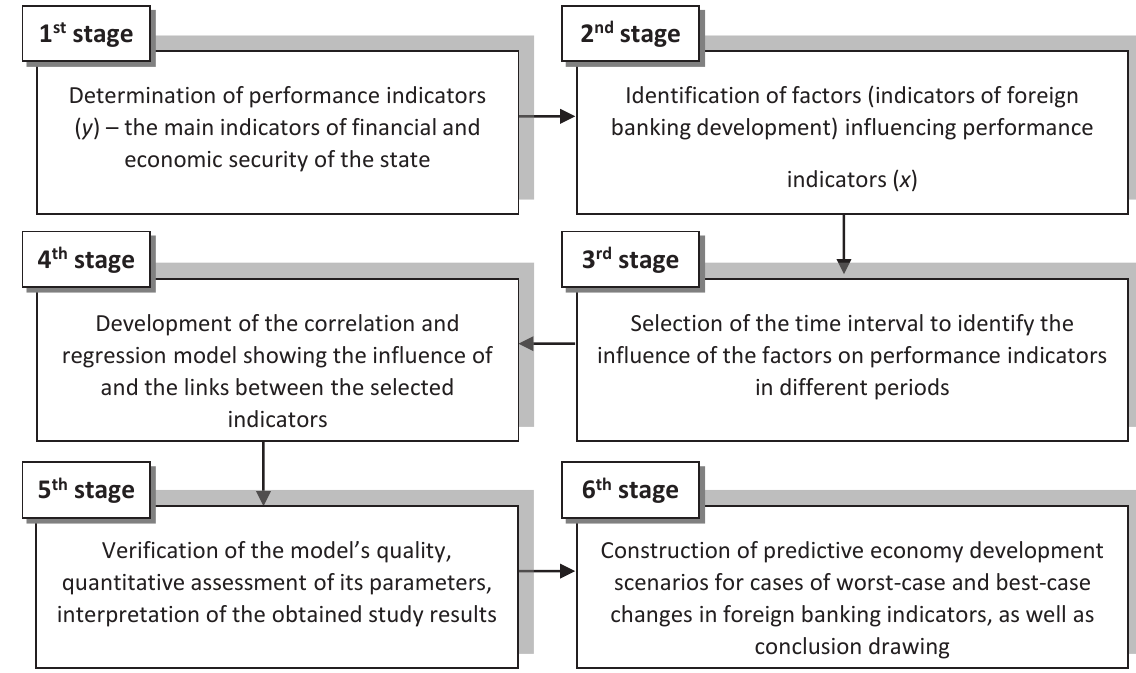
Figure 1. The sequence of the correlation and regression analysis of the influence of foreign banking indicators on the main indicators of financial and economic security of Ukraine